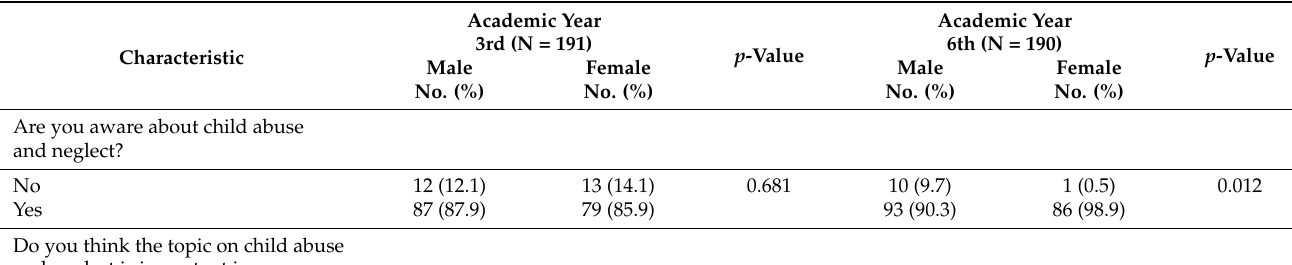
Table 6. Comparison of the Gender Response in Each Academic